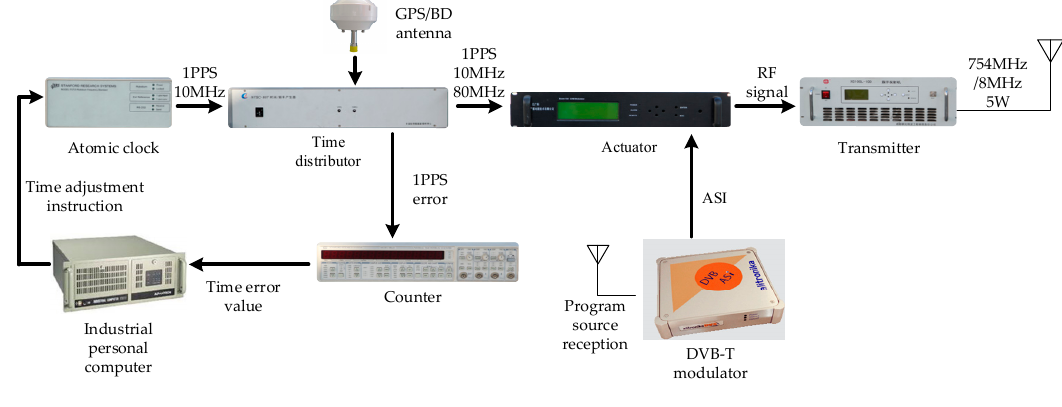
Figure 14. The equipment of MDBBS.